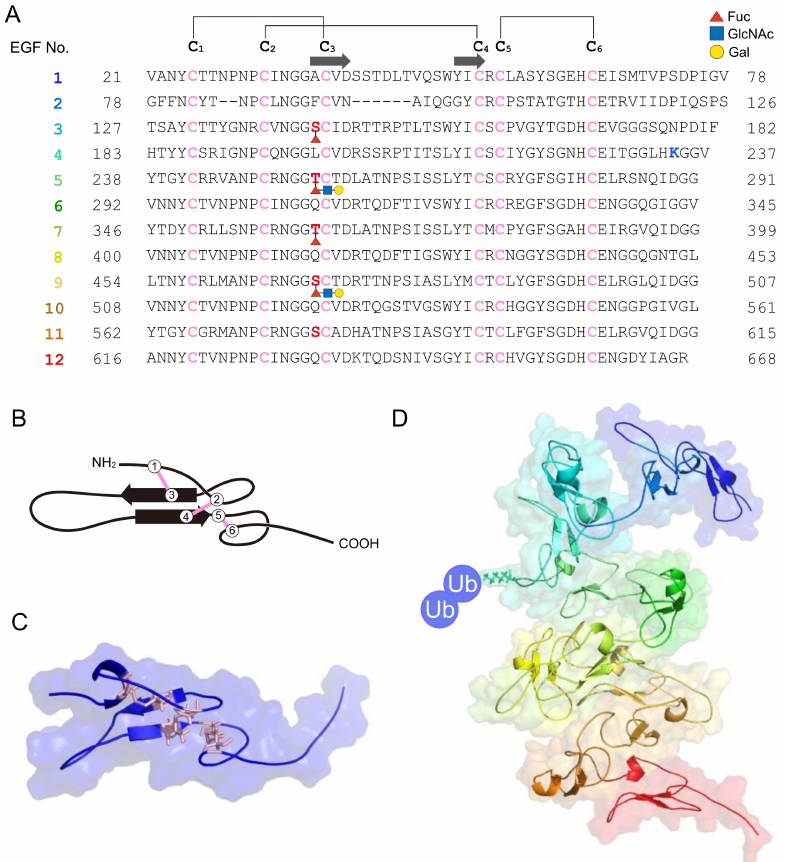
Figure 3. Structure of the 70-kDa-vitelline-coat protein HrVC70, a self/nonself-recognizable sperm receptor in the ascidian Halocynthia roretzi . ( A ) Amino acid sequence of HrVC70 and consensus se- quences for O -fucosylation. Conserved Cys residues are indicated by magenta. Potential fucosylation sites and ubiquitinated sites are indicated by red and blue, respectively. Carbohydrate modifications were investigated by LC/MS/MS, and possible glycosylations were indicated. ( B , C ) Positions of disulfide bridges and anti-parallel β -sheets of the EGF1 domain are illustrated. ( D ) The 3D structure of HrVC70 was predicted by AiphaFold2. Lys 234 , which is ubiquitinated during fertilization, is indicated by the blue ball-and-stick model attaching